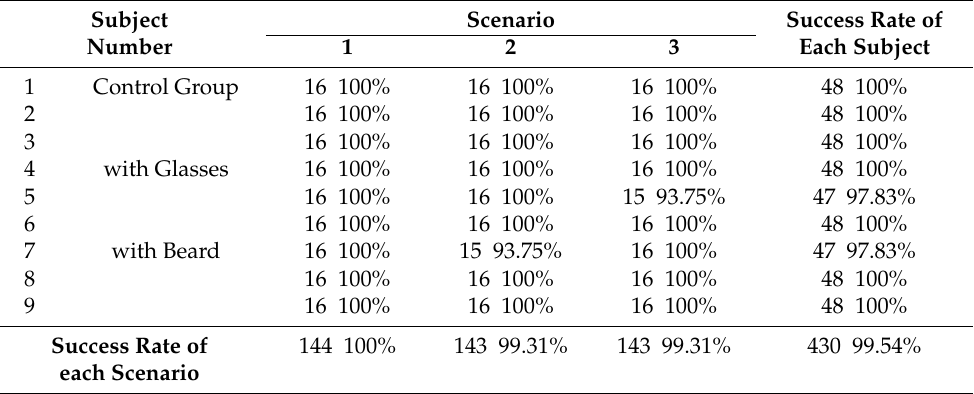
Table 1. The number of successful cup deliveries and the success rate for each subject and scenario are listed. In addition, the total success rate for each subject and each scenario as well as the overall success rate is